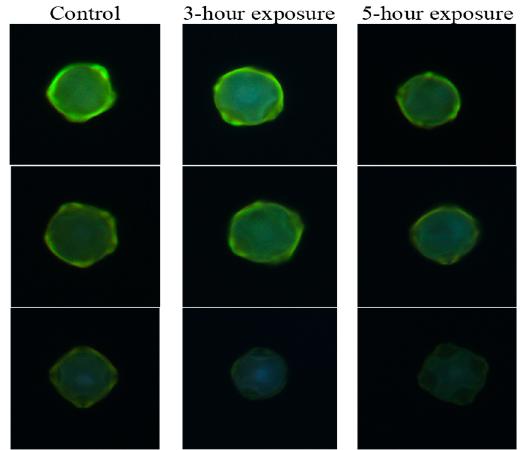
Figure 2. Alnus glutinosa pollen image under the fluorescence microscope (400 × ). The columns show examples of images captured in photos in each of the experimental variant groups: Control—C_1; three-hour exposure—3 h_1; five-hour exposure—5 h_1.